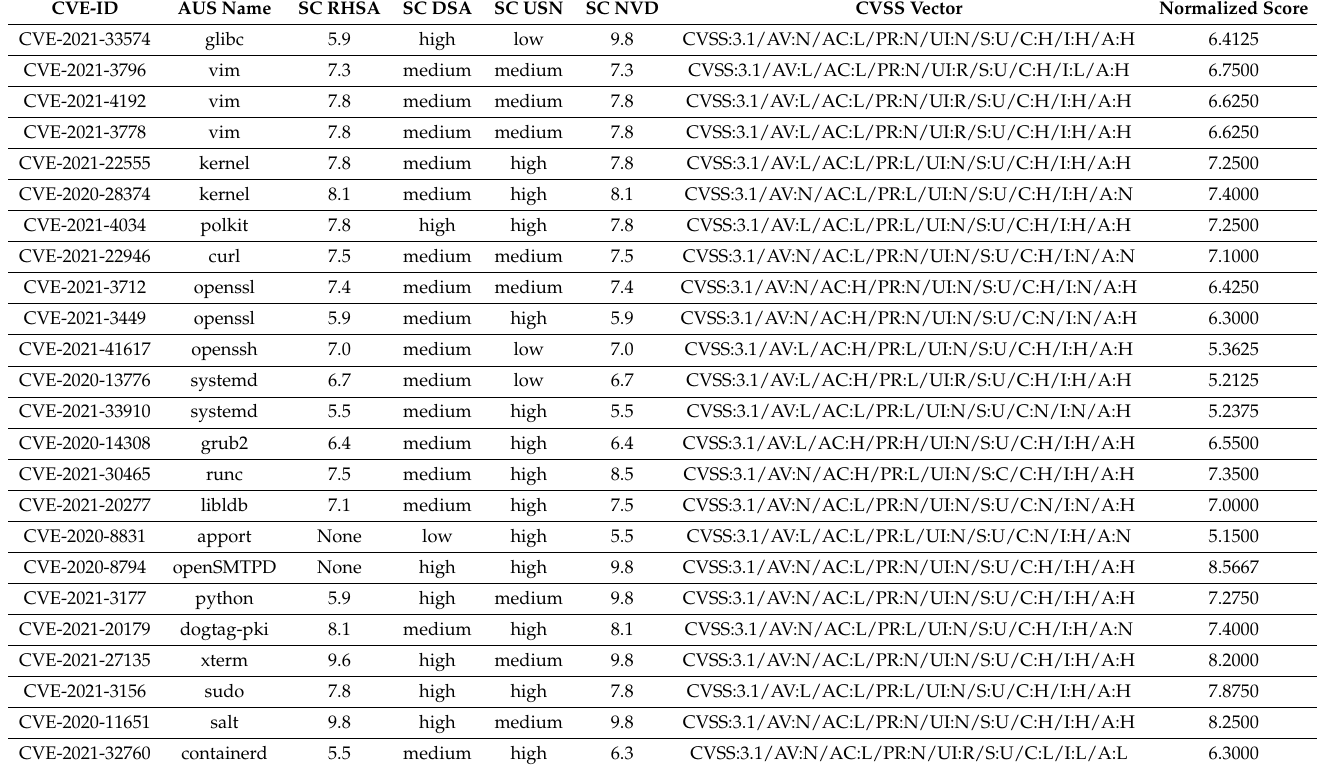
Table 6. The sample of vulnerabilities that affect our test